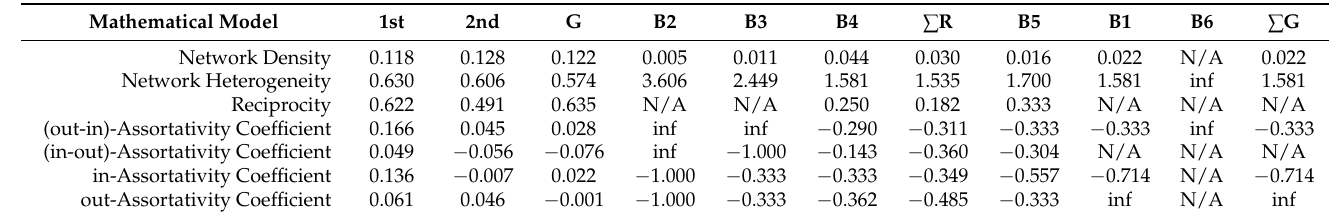
Table A11. Team A’s Matrix of values of the macro analysis mathematical models.